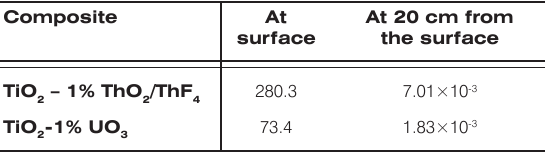
Fig. 1 represents the X-ray diffractograms of some of the studied composites . The diffractograms of TiO ThF composites are identical regardless of the additive 4 content (within the studied concentration interval) (Figs. 1 , 3 -5). The same is also true of the composite TiO -1% UO . Data for the lattice parameters , crystallite 2 3 size and phase composition of the samples are shown in Table 2 . For comparison, the results [ 7] for TiO composites are also included.